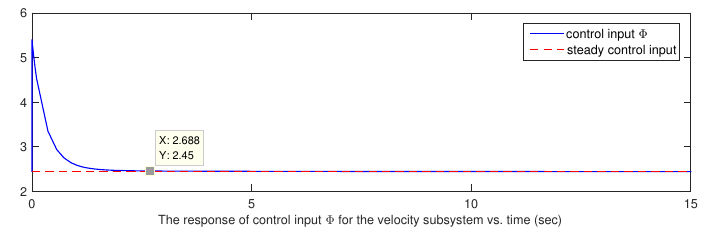
Figure 4. The control input response of the velocity